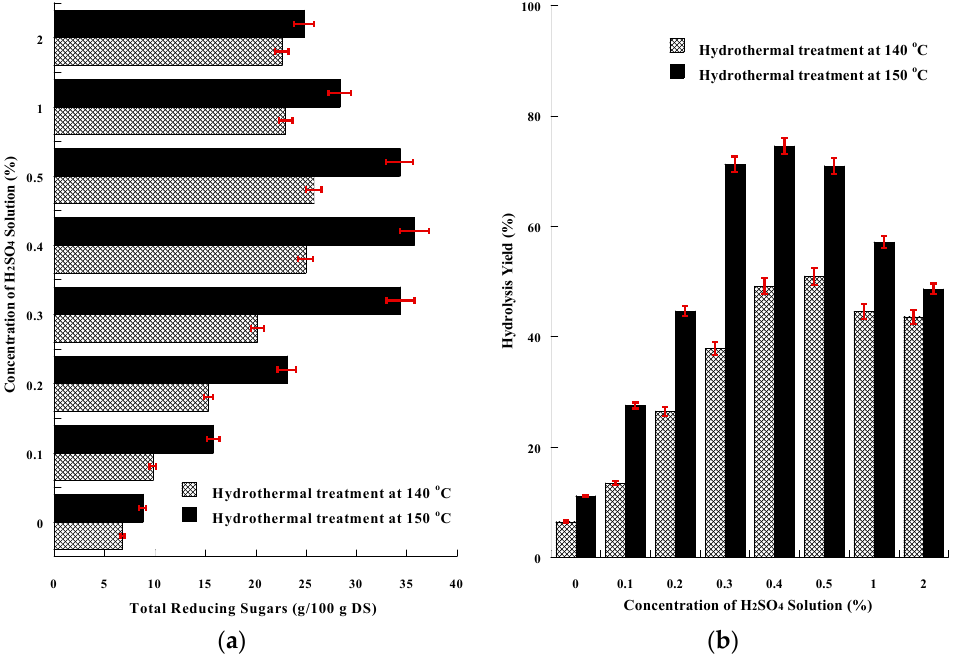
Figure 3. ( a ) Graphical presentation of Total Reducing Sugars (g/L) resulting from the hydrolytic combination of acidic chemical treatment (using various concentrations of acidic), and hydrothermal treatment at 140 or 150 °C. ( b ) Graphical presentation of hydrolysis yield (%) of acidic chemical treatment (using various concentrations of acidic), combined with hydrothermal treatment at 140 or 150 °C. The presented results are the mean of three independent analyses.